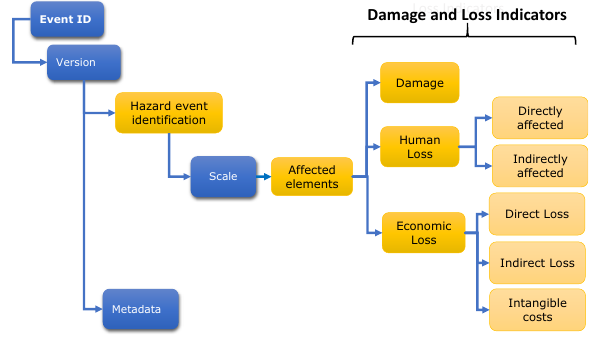
Figure 3. Conceptual data model for damage and loss